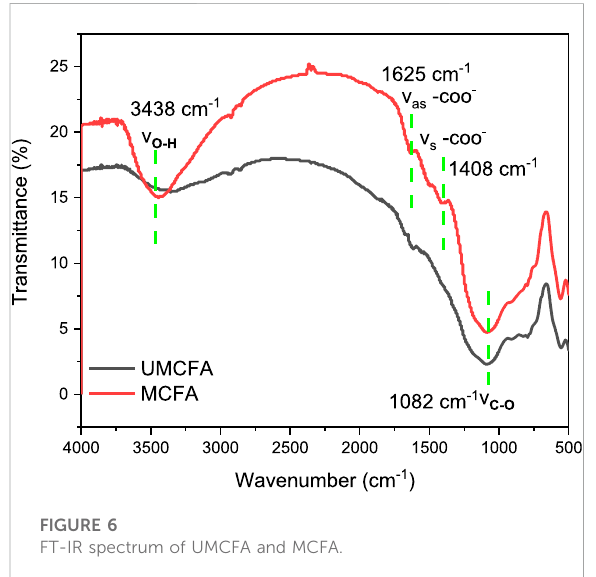
FIGURE 6 FT-IR spectrum of UMCFA and MCFA.